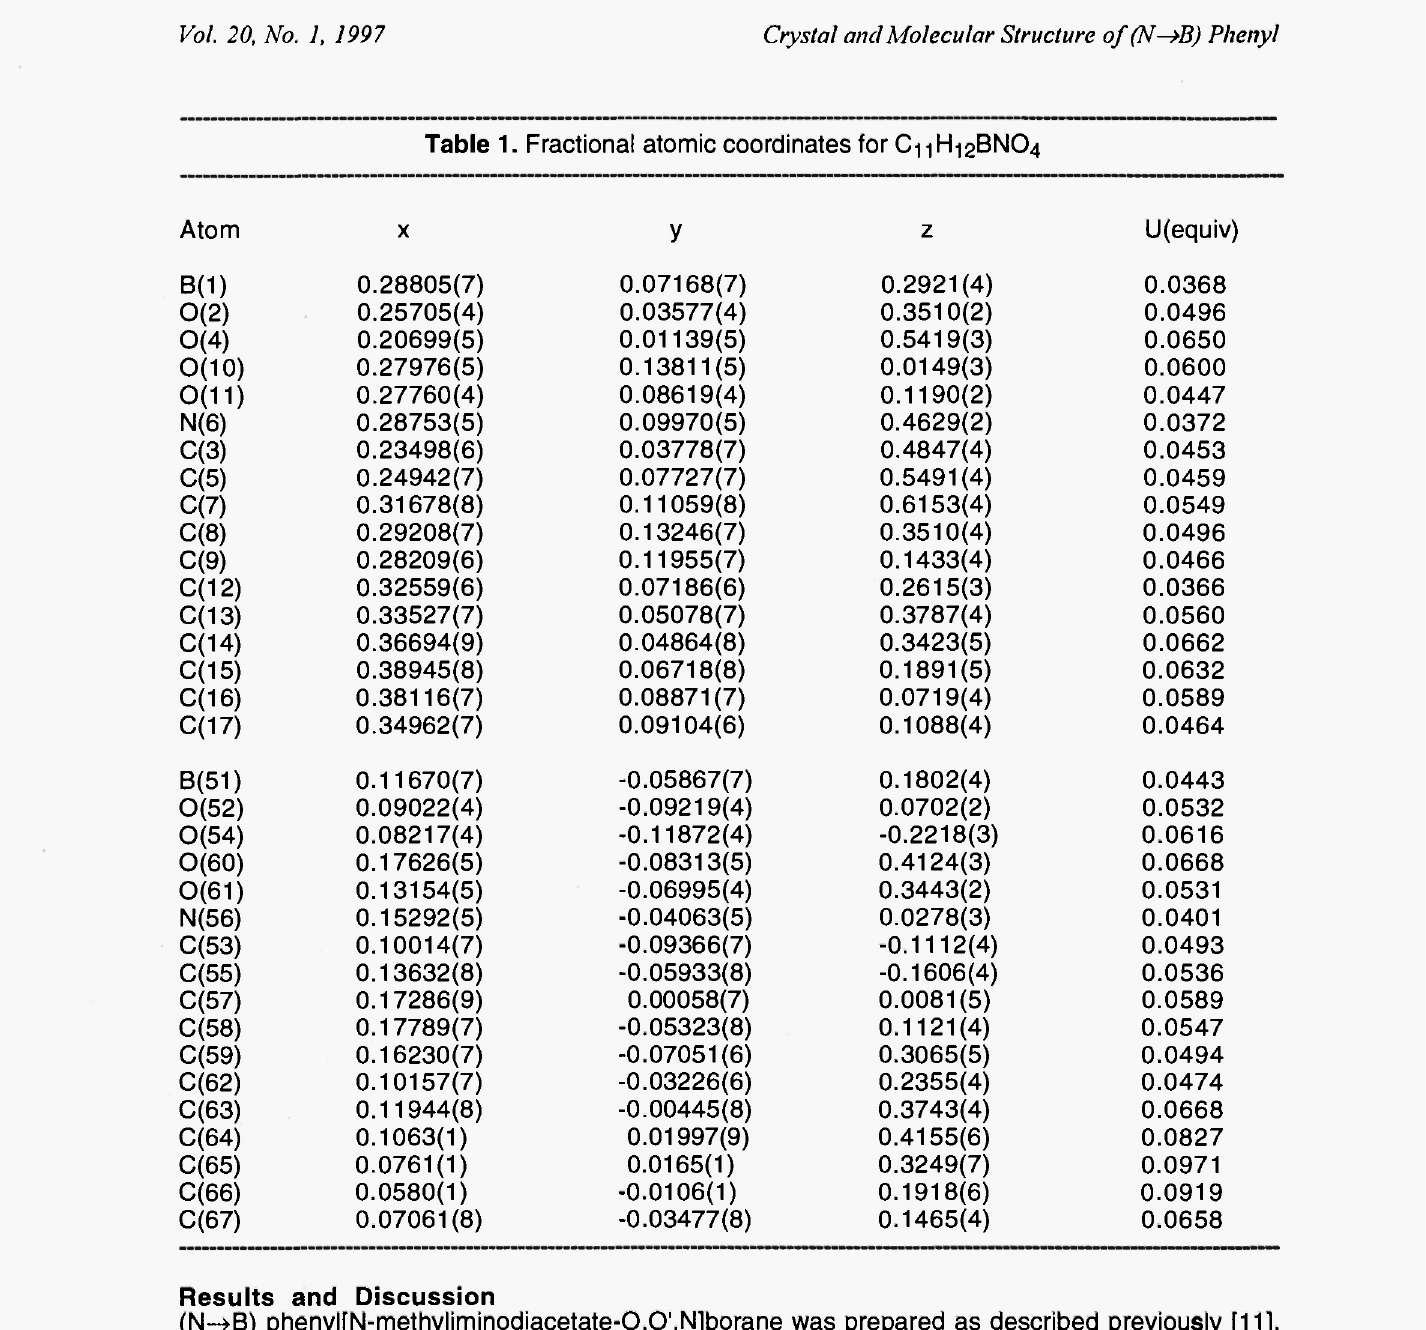
Table 1. Fractional atomic coordinates for